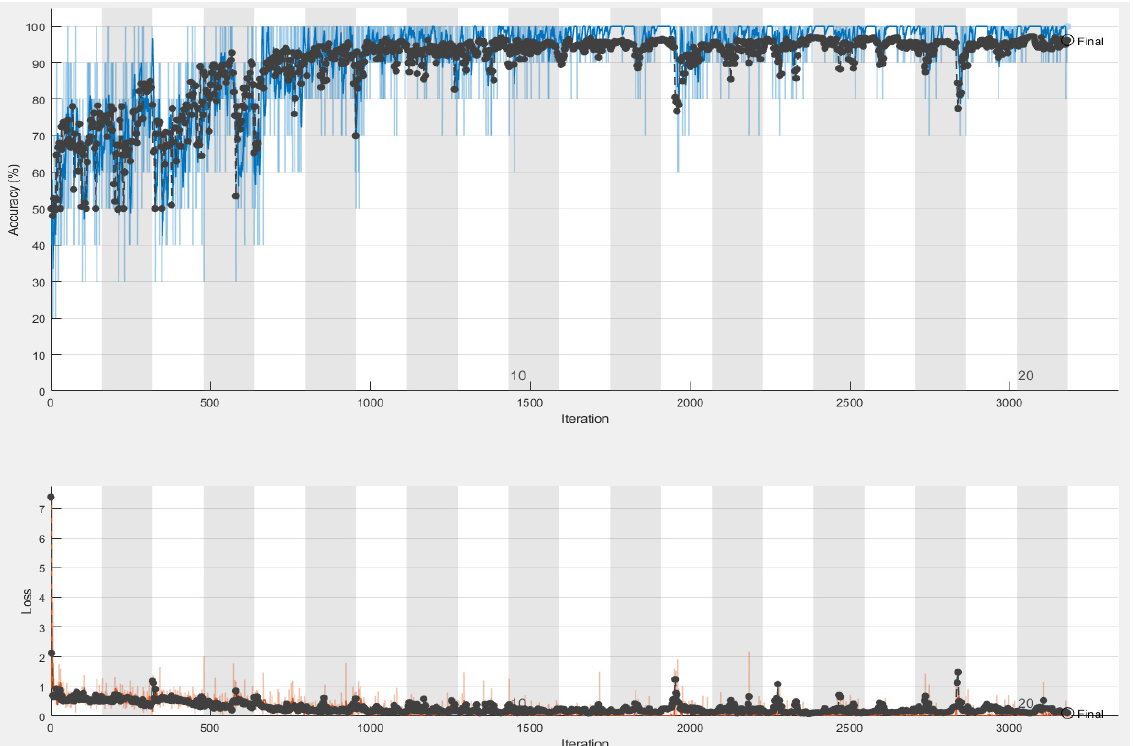
Figure 8. The Accuracy (blue curve) and loss (orange curve) results given by VGG-16 simulation: 96.25% of success accuracy with 20 epochs.